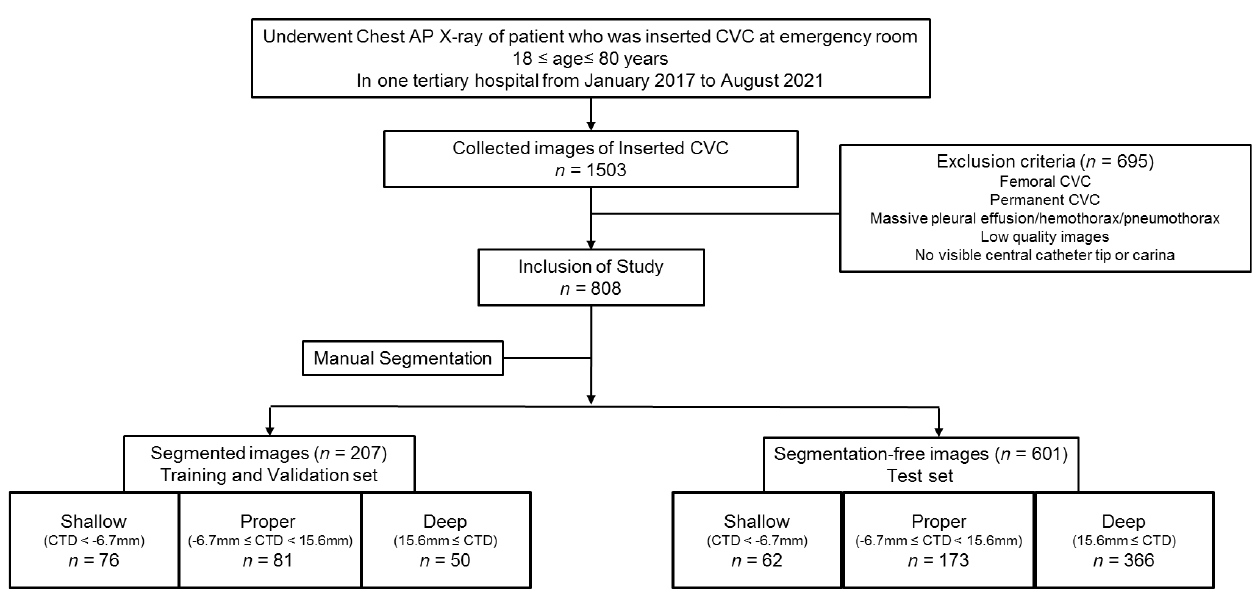
Figure 1. Flowchart of data collection for training/validation with segmented images and a test set with segmentation-free images in the study. All the images are classified according to CTD. CVC, central venous catheter; CTD, distance from the carina to tip of the catheter.